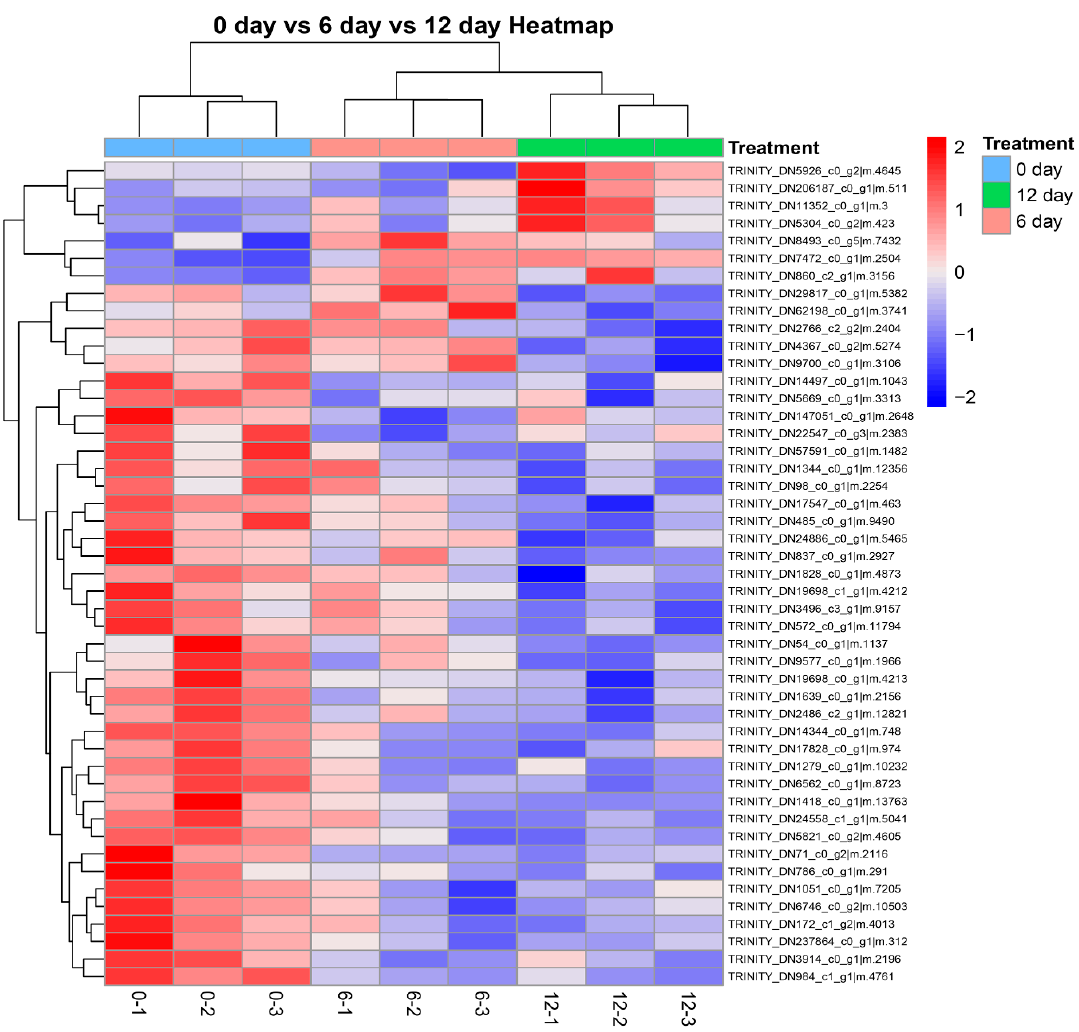
Figure 4. Hierarchical cluster analysis of differentially significant expressed proteins (DSEPs) in grouper fillets on Day 6 and Day 12 compared with Day 0. The right side of each corresponding row is the protein’s Uniprot number. Different colors represent the different relative abundance of proteins (lower intensity are shown in blue and red represents higher intensity).